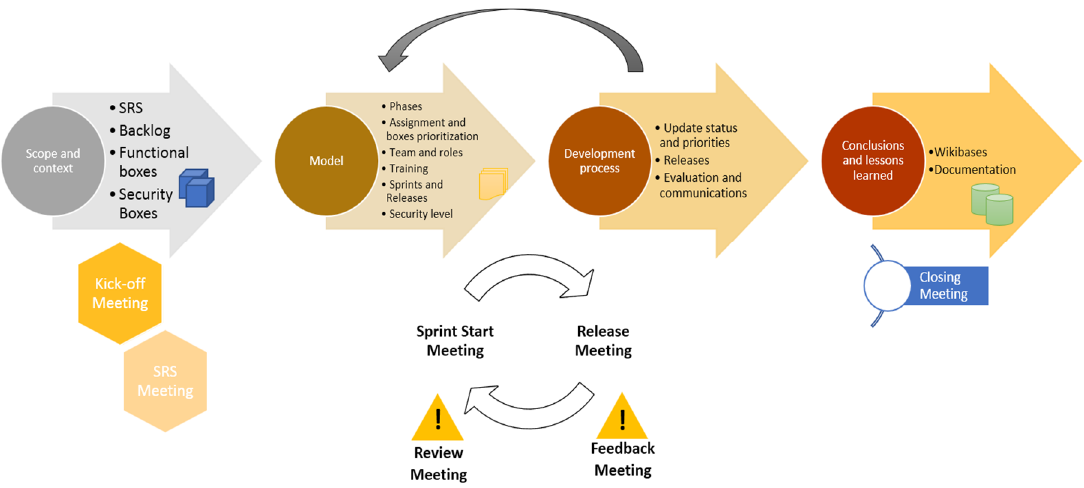
Figure 3. Figure 3. Process.